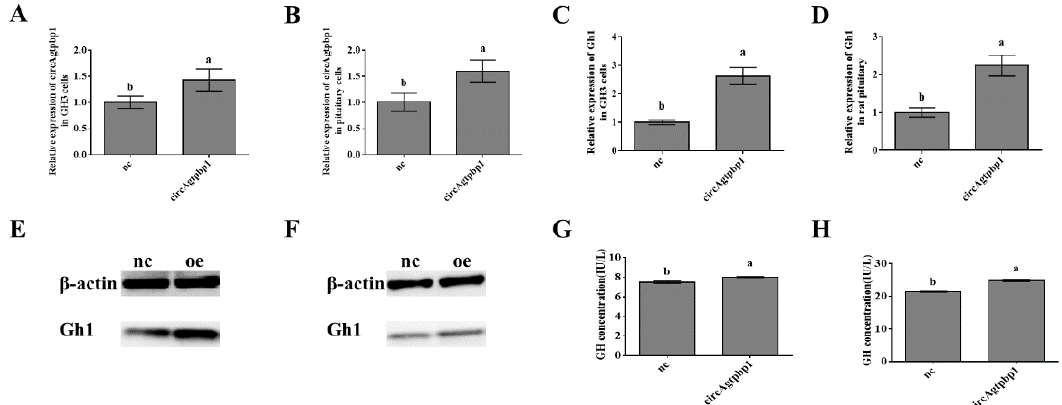
Figure 4. Effects of overexpressing circAgtpbp1 on Gh1 transcription. ( A ) The expressions of circAgtpbp1 were determined with RT–qPCR in GH3 cells transfected with circAgtpbp1 overexpression vector. ( B ) The expressions of circAgtpbp1 were determined with RT–qPCR in pituitary cells transfected with circAgtpbp1 overexpression vector. ( C ) The expressions of Gh1 were determined with RT–qPCR in GH3 cells transfected with circAgtpbp1 overexpression vector. ( D ) The expressions of Gh1 were determined with RT–qPCR in pituitary cells transfected with circAgtpbp1 overexpression vector. ( E ) The expressions of Gh1 were determined with WB in GH3 cells transfected with circAgtpbp1 overexpression vector. ( F ) The expressions of Gh1 were determined with WB in pituitary cells transfected with circAgtpbp1 overexpression vector. ( G ) ELISA experiment detected GH secretion in GH3 cells after transfected with circAgtpbp1 overexpression vector. ( H ) ELISA experiment detected GH secretion in pituitary cells after transfected with circAgtpbp1 overexpression vector. At least three replicates of each experiment were performed. Mean values and standard deviations (SD) of data are shown. One-way ANOVA was applied to determine statistical significance. p < 0.05 was considered significant. Different letters (a,b) indicate significant differences between groups ( p < 0.05). *, p < 0.05.